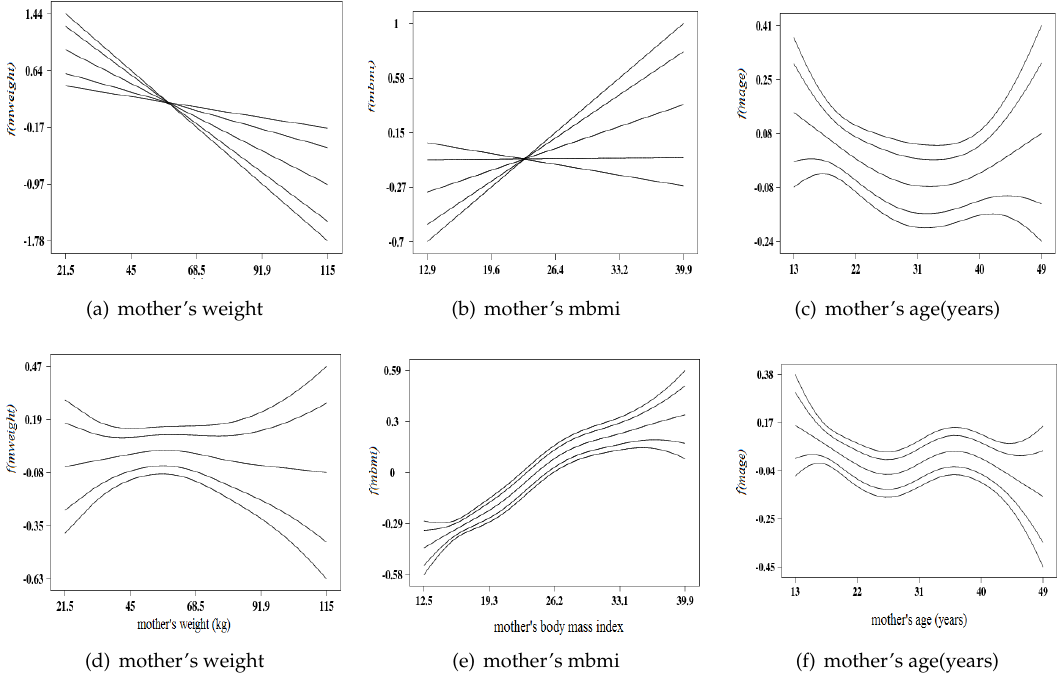
Figure 2. Non-linear effects of ( a ) Mother’s weight; ( b ) mother’s body mass index; and ( c ) mother’s age at birth Model A Binary logit model in upper panel ( d ) mother’s weight; ( e ) mother’s body mass index; and ( f ) mother’s age at birth for Model B , Multinomial model on lower panel